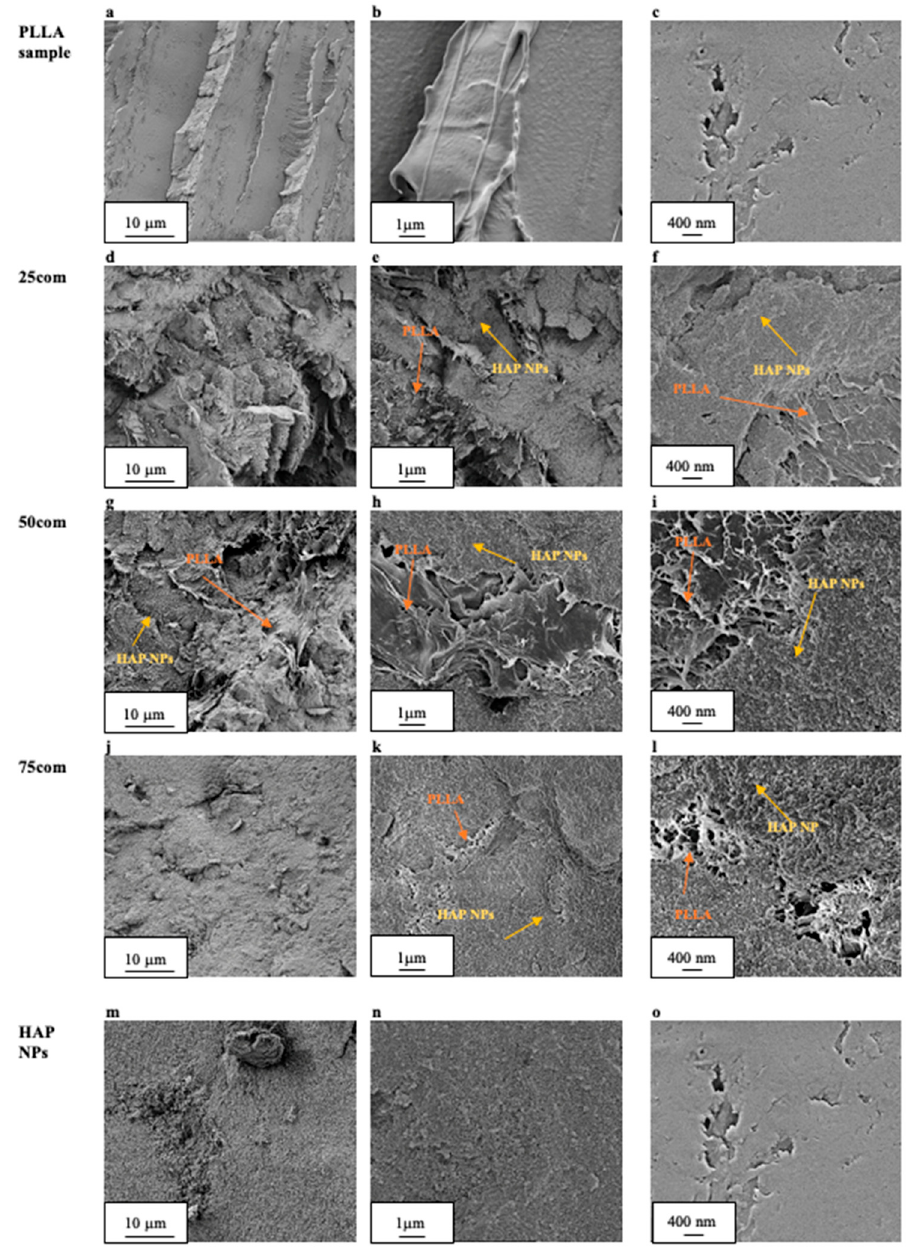
Figure 4. Fractures of samples and composites after the three-point bending test; PLLA ( a – c ), 25com ( d – f ), 50com ( g – j ), 75com ( j – l ) and HAP NPs ( m – o ).